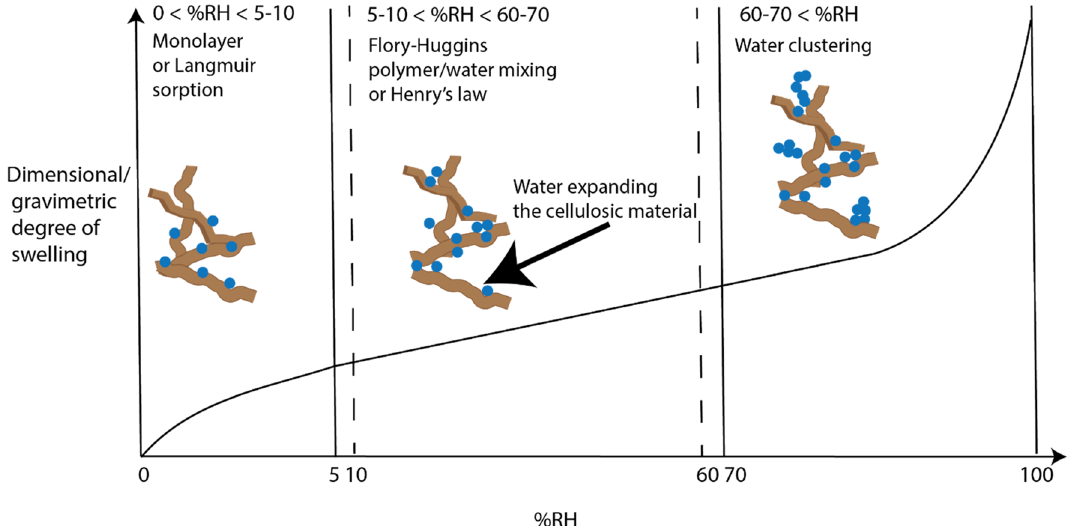
Figure 1. Illustration of water sorption models as described by Belbekhouche et al. 17 (for the MFC type of nanocellulose) and Hakalahti et al., for TEMPO-oxidized CNF 16